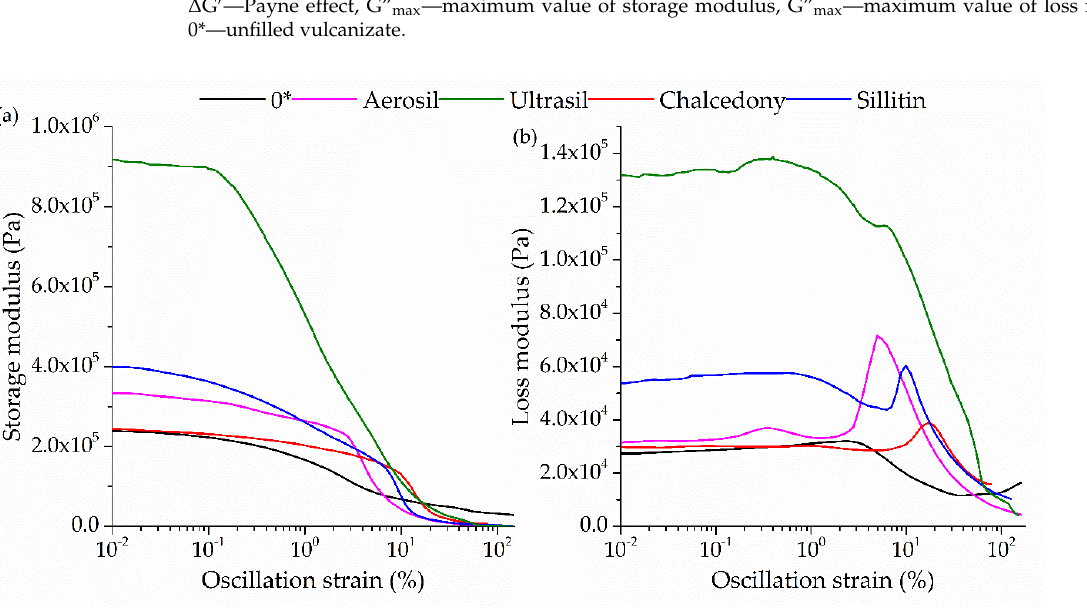
Table 5. Hysteresis losses and Mullins effect of unfilled and filled CR/BR/nano-Fe 2 O 3 vulcanizates.